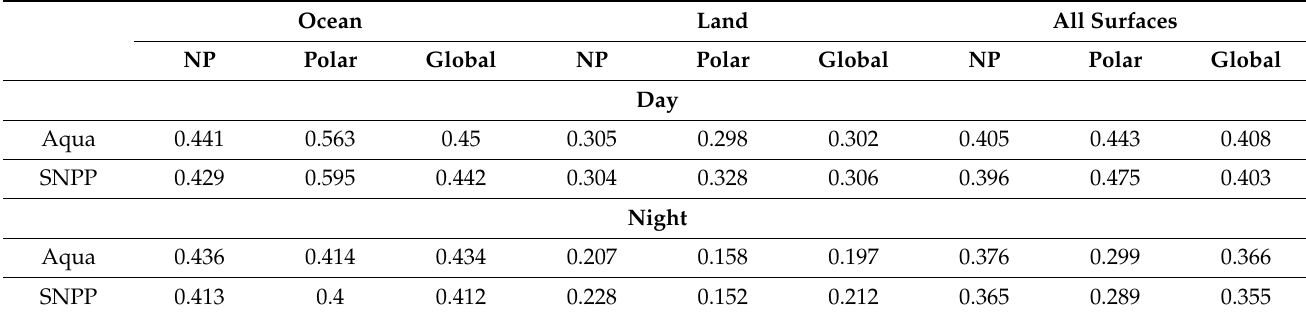
Table 3. Same as Table 2, except for the liquid water cloud amount.